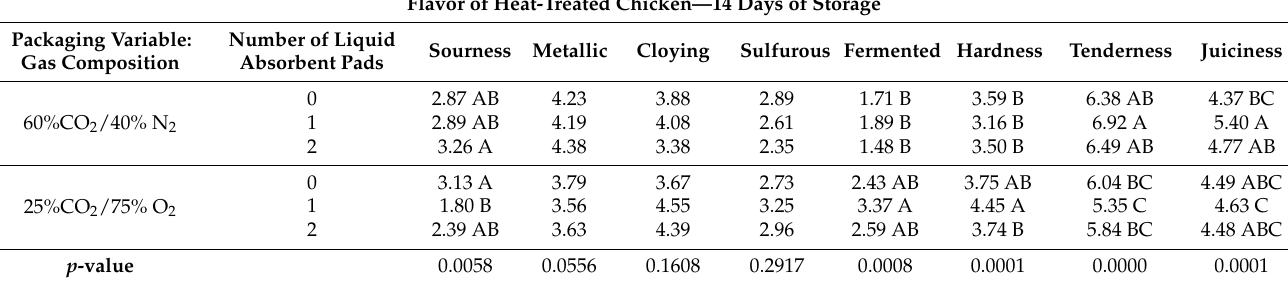
Table A3. Sensory intensity scores (scale 1–9) for flavor attributes for heat-treated samples and odor attributes for raw chicken breast fillets stored for 14 days in modified atmospheres of 60% CO 2 /40% N 2 and 75% O 2 /25% CO 2 with 0, 1, or 2 liquid absorbent pads (Experiment 1). Levels sharing a letter are not significantly different ( p < 0.05) between the chicken breasts samples, as measured by two-way ANOVA and Tukey’s multiple comparison